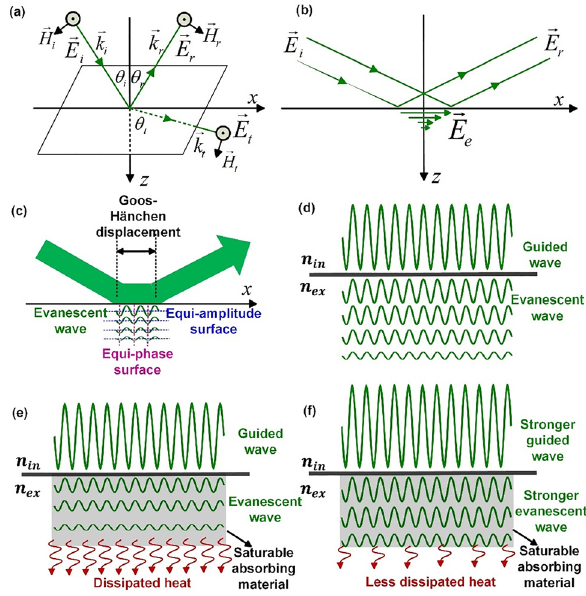
Figure 10: Evanescent field characteristics at the vicinity of a waveguiding interface. (a) Reflection and refraction by a general planar boundary when the lightbeamincidentfromamediumwithahigherrefractiveindextoa medium with a lower refractive index. (b) Total reflection in the incidence plane. (c) Detailed characteristics near the boundary with evanescent wave generation and Goos – Hänchen displacement. (d) Free-propagating characteristics of both the guided wave and evanescent wave. Waveguiding characteristics with externally coated saturable absorbing material when the guided wave is (e) weak and (f) strong,